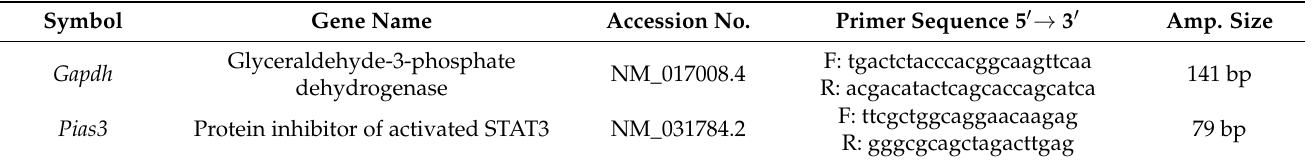
Table 2. Sequences of primers used in the current